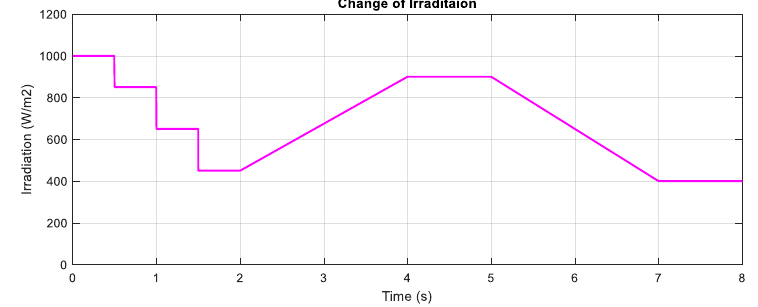
Figure 7. The change of irradiation at T = 25 °C.